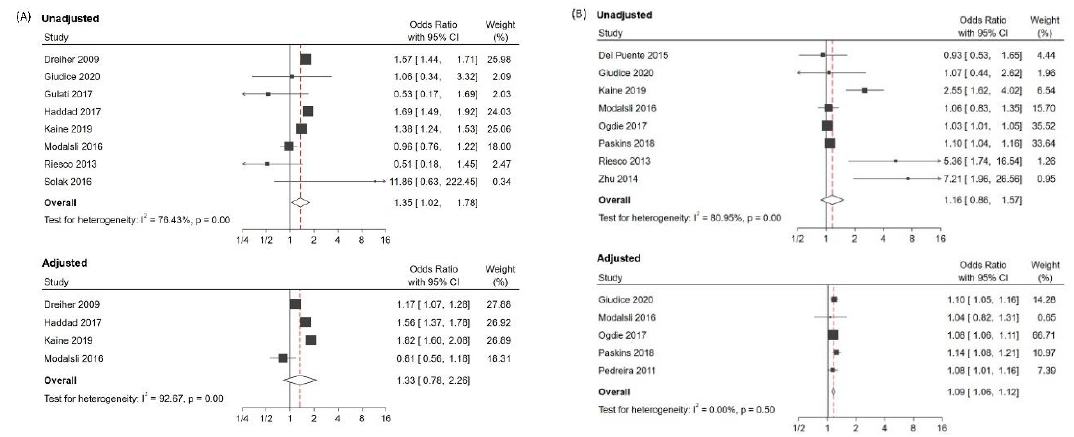
Figure 3. Forest plots of the unadjusted and adjusted odds ratio (OR) of osteoporosis ( A ) and fractures ( B ). CI, confidence interval.